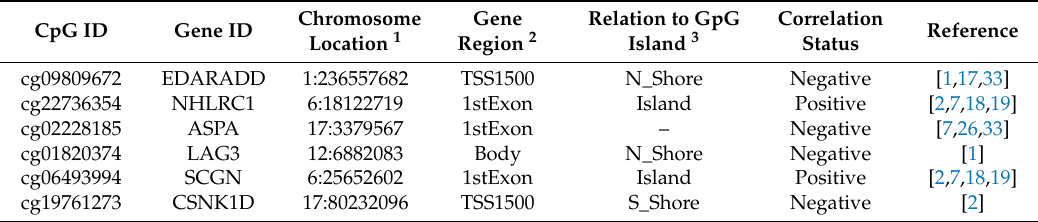
Table 3. Information of 6 selected age-related CpG